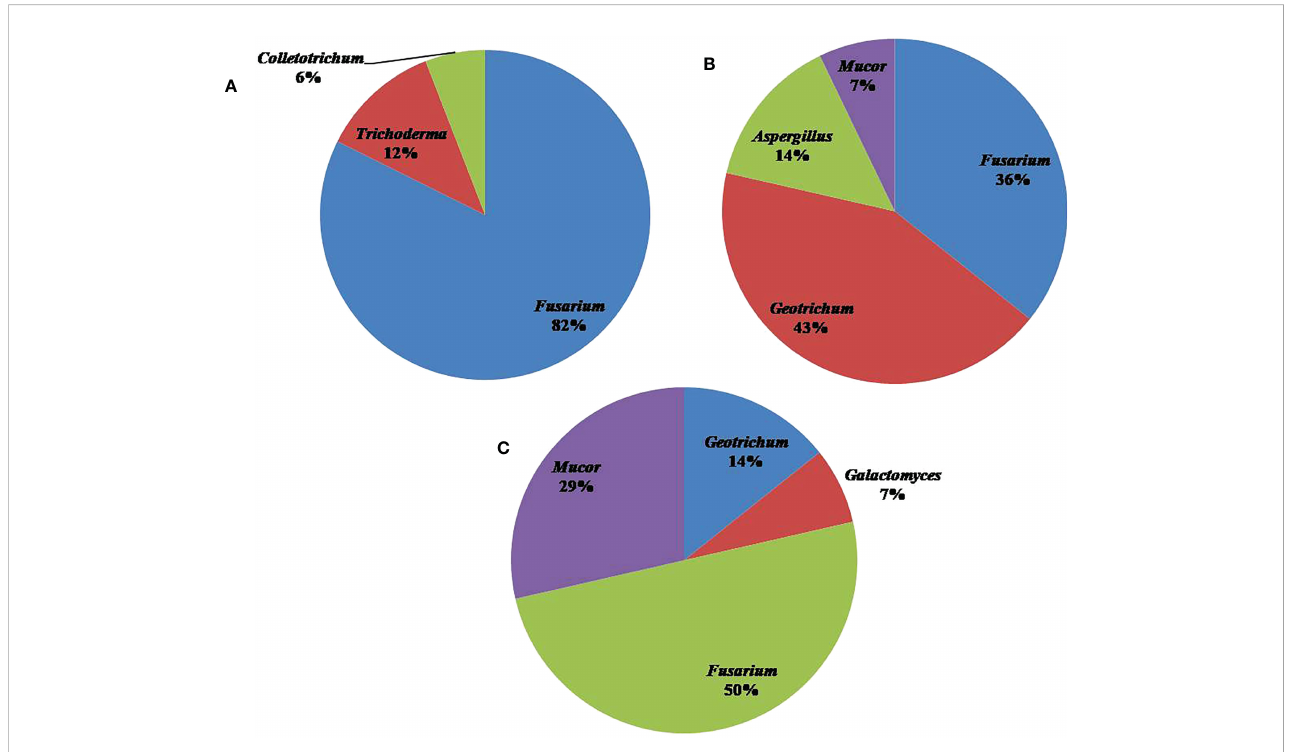
FIGURE 4 Pie chart representing the distribution and diversity of fungal genera in (A) Srinagar, (B) Kishtwar, and (C) Ramban.